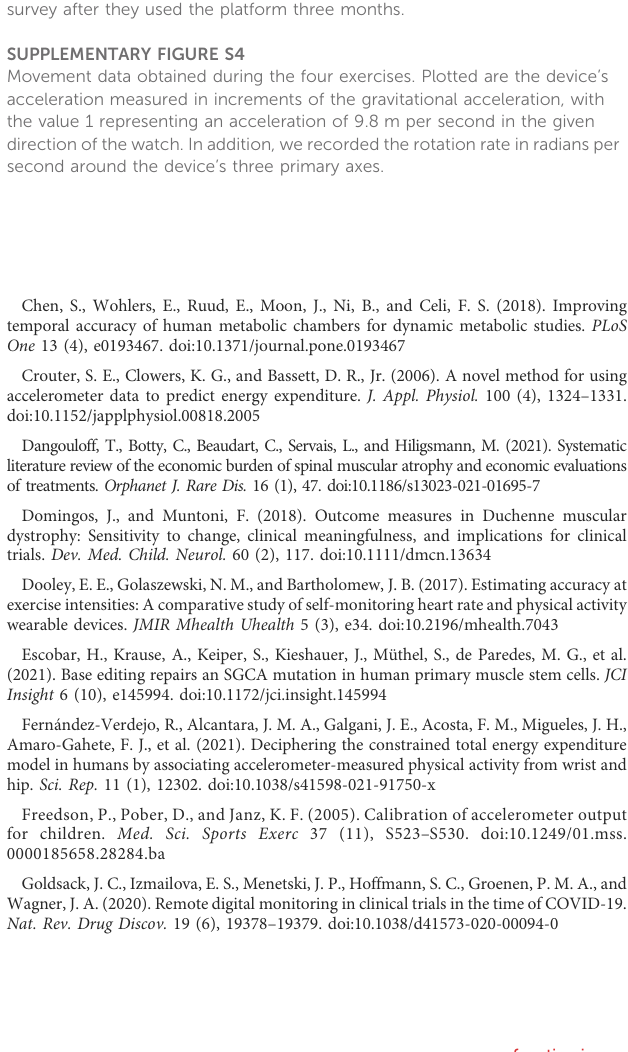
SUPPLEMENTARY FIGURE S1 (A) On the platform, the therapist creates weekly exercise plans for the patients and, (B, C) , can monitor their compliance to adjust the plan accordingly to the patients ’ feedbacks. SUPPLEMENTARY FIGURE S2 (A) Disease distribution of the patients in the orientation phase ( n = 50) and (B) selection of the three exercises for the validation study based on the high acceptance. The feedbacks to the exercises obtained by patients using the suMus web-based platform in the period April-October 2021 were recorded and the three exercises for the upper limbs displaying a high acceptance pro fi le (high number of executions, high number of answers “ The exercise is just right ” and “ I had no pain during or after the exercise ” ) were selected.